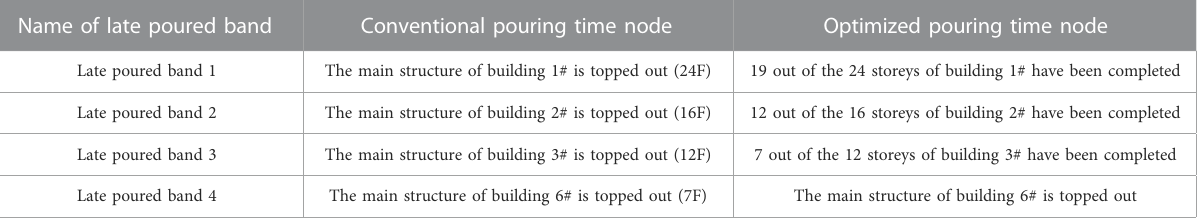
TABLE 6 Time nodes of pouring work of late poured band.